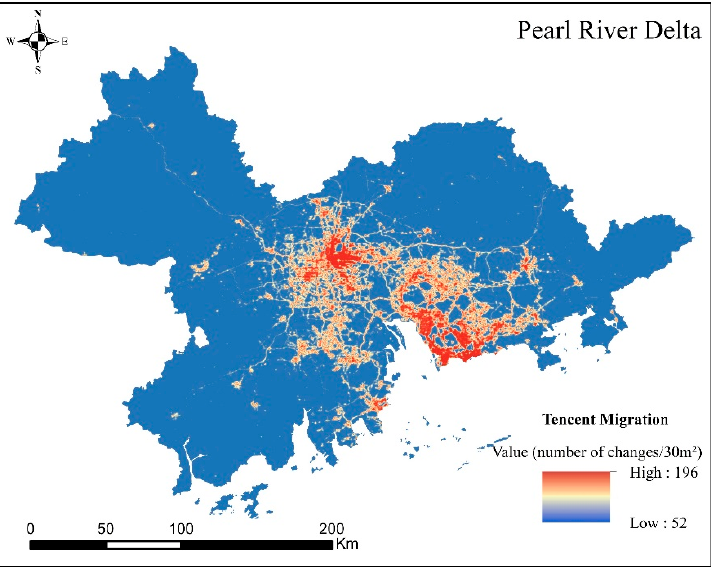
Figure 4. Population changes in PRD urban agglomeration.